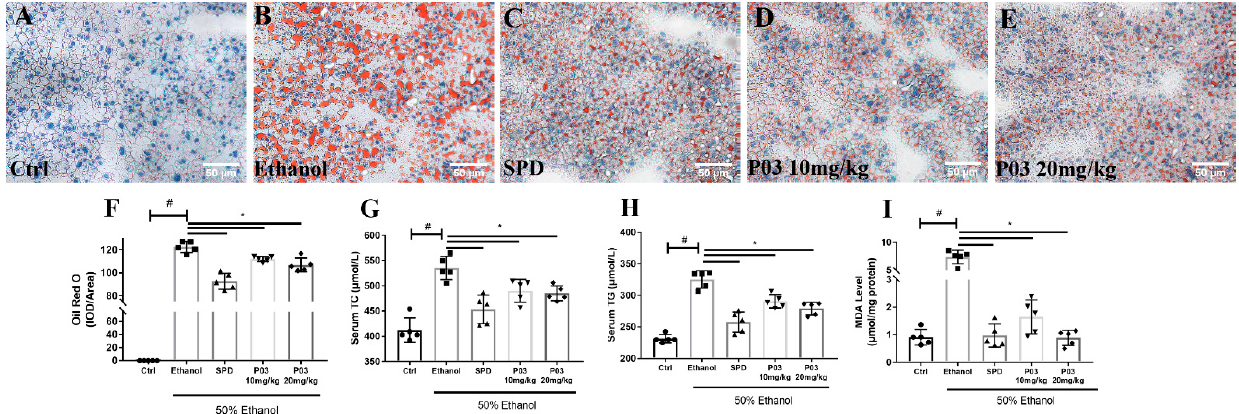
Figure 5. Alterations in lipid metabolism in mice with binge alcohol exposure. ( A – E ) Representative images of histological liver sections after Oil Red O staining. Sections were visualized using Bioquant Osteo (20×) and quantified using Image Pro plus software. ( F ) The corresponding quantification of Oil Red O staining in different groups. ( G , H ) Serum triglycerides and total cholesterol levels in different groups. ( I ) The levels of hepatic malondialdehyde (MDA) were detected colorimetrically in different groups. Comparisons were made with one-way ANOVA. Values are represented as mean ± SD. (Compared to Ctrl, # p < 0.05. Compared to ethanol, * p < 0.05) ( n = 5).